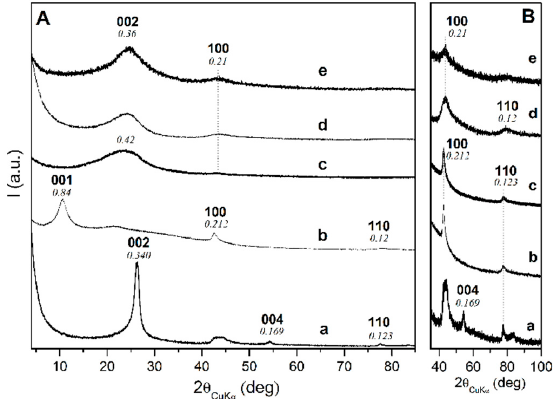
Figure 2. X-ray diffraction patterns (Cu K α ) of the high-surface-area graphite (HSAG) ( a ), of the derived GO ( b ) and eGO ( c ), and of one of the used carbon black, CB N110 ( d ) and of the corresponding oxidized sample ( e ).